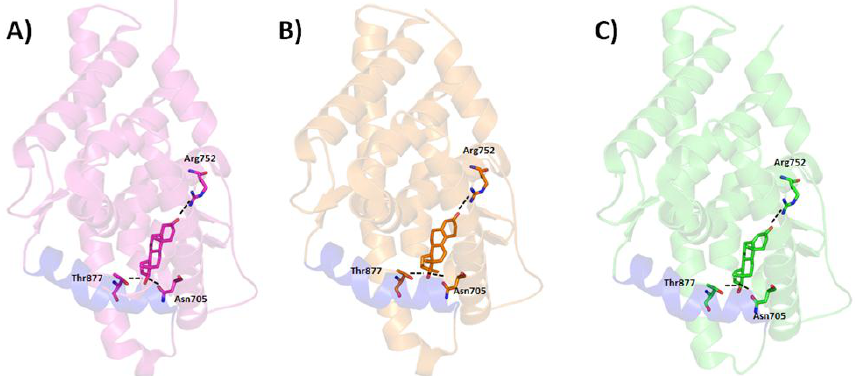
Figure 3. Binding of AR agonists dihydrotestosterone DHT ( A ), Testosterone ( B ), and R1881 ( C ) in the active site of AR ligand binding pocket. The agonists were drawn in stick model and the protein in ribbon model. The important residues were displayed in stick model. The black dotted lines represent the hydrogen bond interactions between the agonists and critical residues in the active site of AR ligand binding domain.